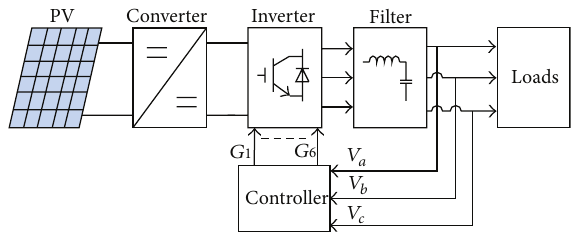
Figure 1: Structure circuit of the three-phase inverter